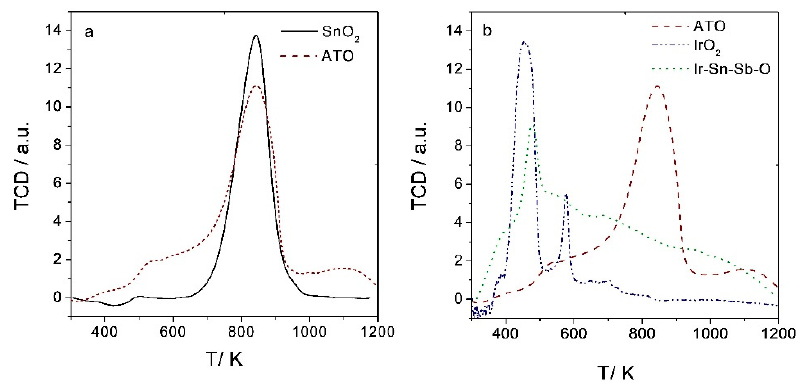
Figure 6. TPR profile of ( a ) commercial SnO 2 (—) and ATO (- - -) and ( b ) ATO (- - -), IrO 2 (- ∙ ∙ ) and Ir-Sn-Sb-O ( ∙ ∙ ∙ ) at 10 °C min − 1 heating rate.